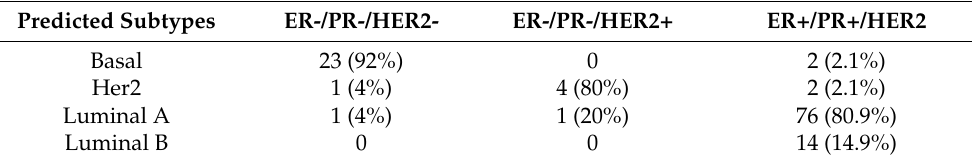
Table 6. Evaluation of selected genes by breast cancer subtype